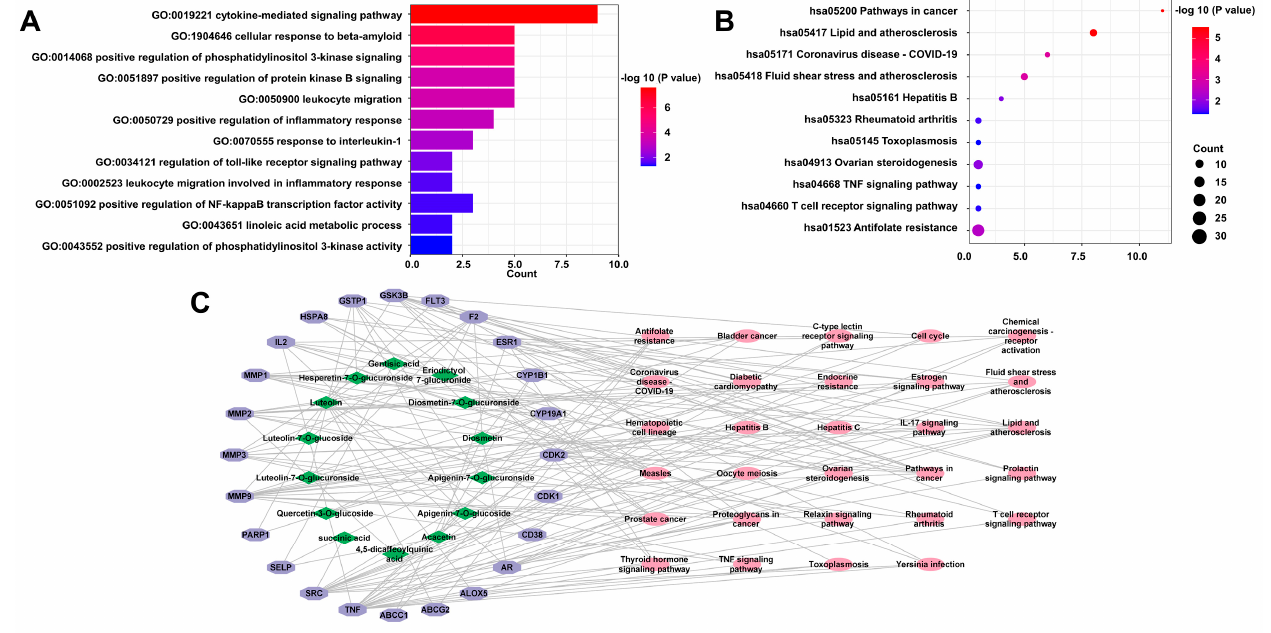
Figure 2. Prediction results of network pharmacology study. ( A )—GO enrichment analysis; ( B )— KEGG pathway analysis; ( C )—“Component − target − pathway” multivariate network.